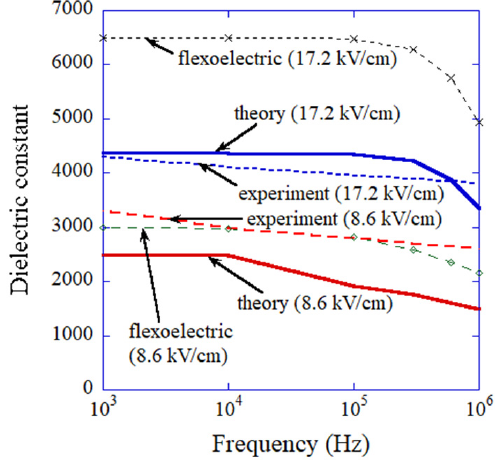
Figure 11. The dielectric constant according to the numerical simulations of the ODE model for dynamic response of flexoelectric polarization of BaTiO 3 nanocubes taking into account the presence of ferroelectric polarization the results solely by flexoelectric polarization are also shown. The experi- mental data are also shown for comparison. Reprinted with permission from Ref. [87]. Copyright 2022,